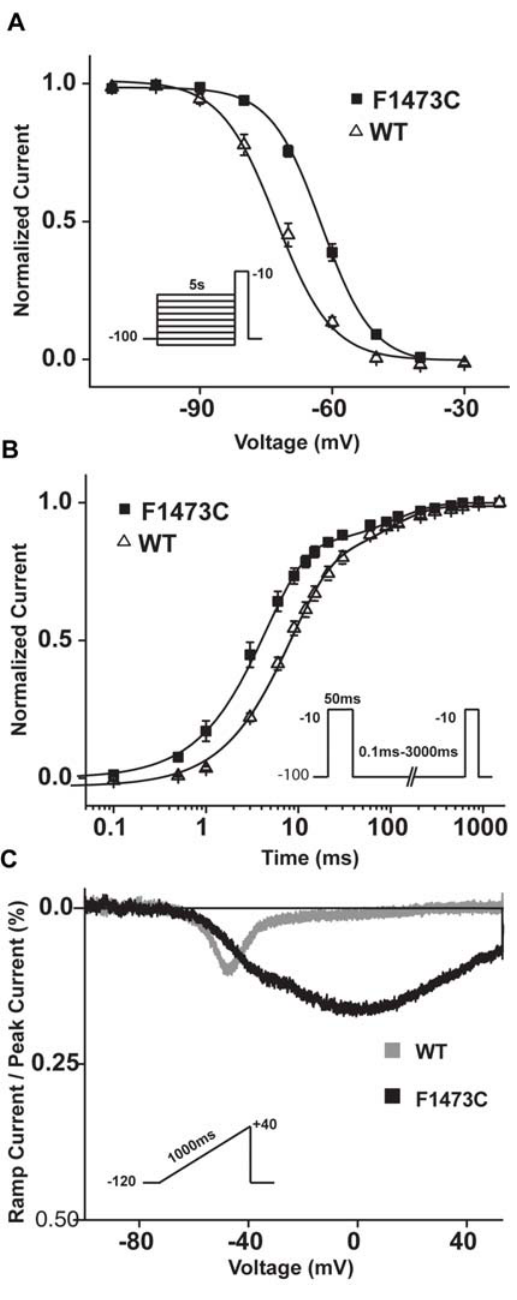
Figure 4. The F1473C mutation has multiple biophysical conse- quences. A. The F1473C mutation causes an 8.8 6 1.6 mV depolarizing shift in the steady state availability curve. Data shown for WT (n=9, open triangles) and F1473C (filled squares, n=25) channels. B. Mutation at F1473C speeds the time course of recovery from inactivation as measured at 2 100 mV following a 50 ms pulse to 2 10 mV. WT (open triangles, n=5) and F1473C (closed squares, n=5). C. Normalized WT (grey) and F1473C (black) currents in response to a ramp in voltage from 2 120 mV to + 40 mV (see Methods S1) over the course of 1s reveal F1473C-enchanced inward current over a broad range of voltage. Shown are averaged TTX-sensitive currents for WT (light grey, n=4) and F1473C (black, n=11) channels. Note the inverted bell-shaped response of WT channels to this protocol reveals ‘‘window’’ of current for WT channels (see text for